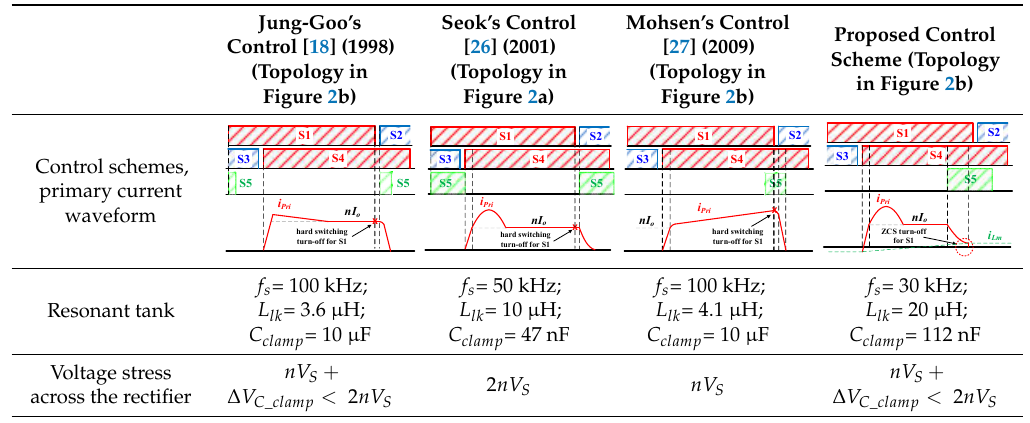
Figure 2. Two kinds of active-clamp circuits employed at the secondary side of the phase-shifted full- bridge (PSFB) converter: ( a ) the topology in Reference [26]; ( b ) the topologies in References [18,27,28]. Table 2. Comparison of the control scheme, resonant tank, and voltage stress of the rectifier of the active-clamp circuits in Figure 2.